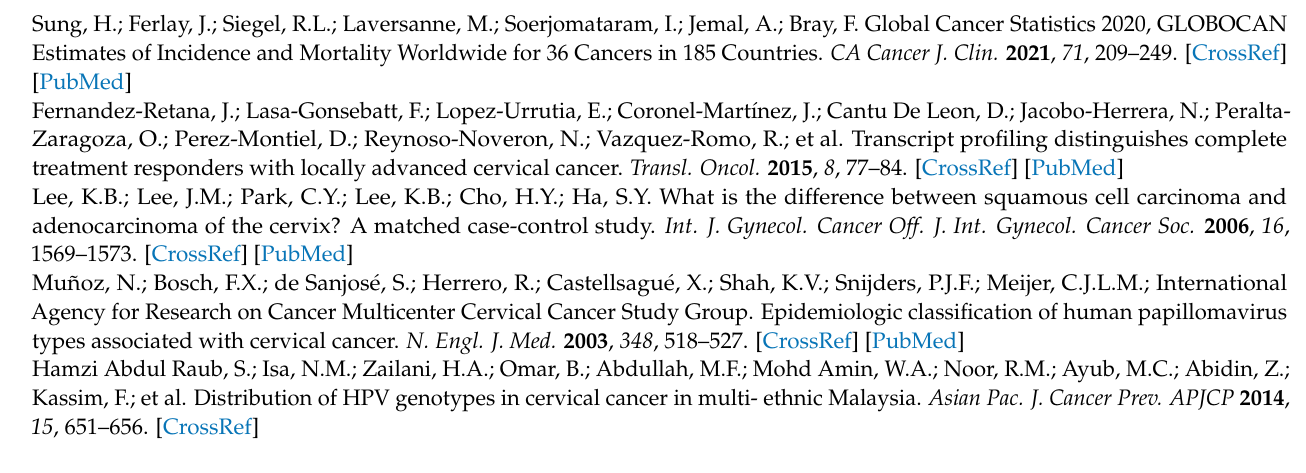
Table S2. HPV data from Mexican-Mestizo cohort, Table S3. Differential expressed genes between the two histological types in TCGA cohort, Table S4. Differential expressed genes between the two histological types in Mexican-mestizo cohort (GSE56303), Table S5. 70 DEGs concordant between TCGA and Mexican-mestizo cohort, Figure S1. GABRB2, TSPAN8 and TMEM40 Overall survival of TCGA CC